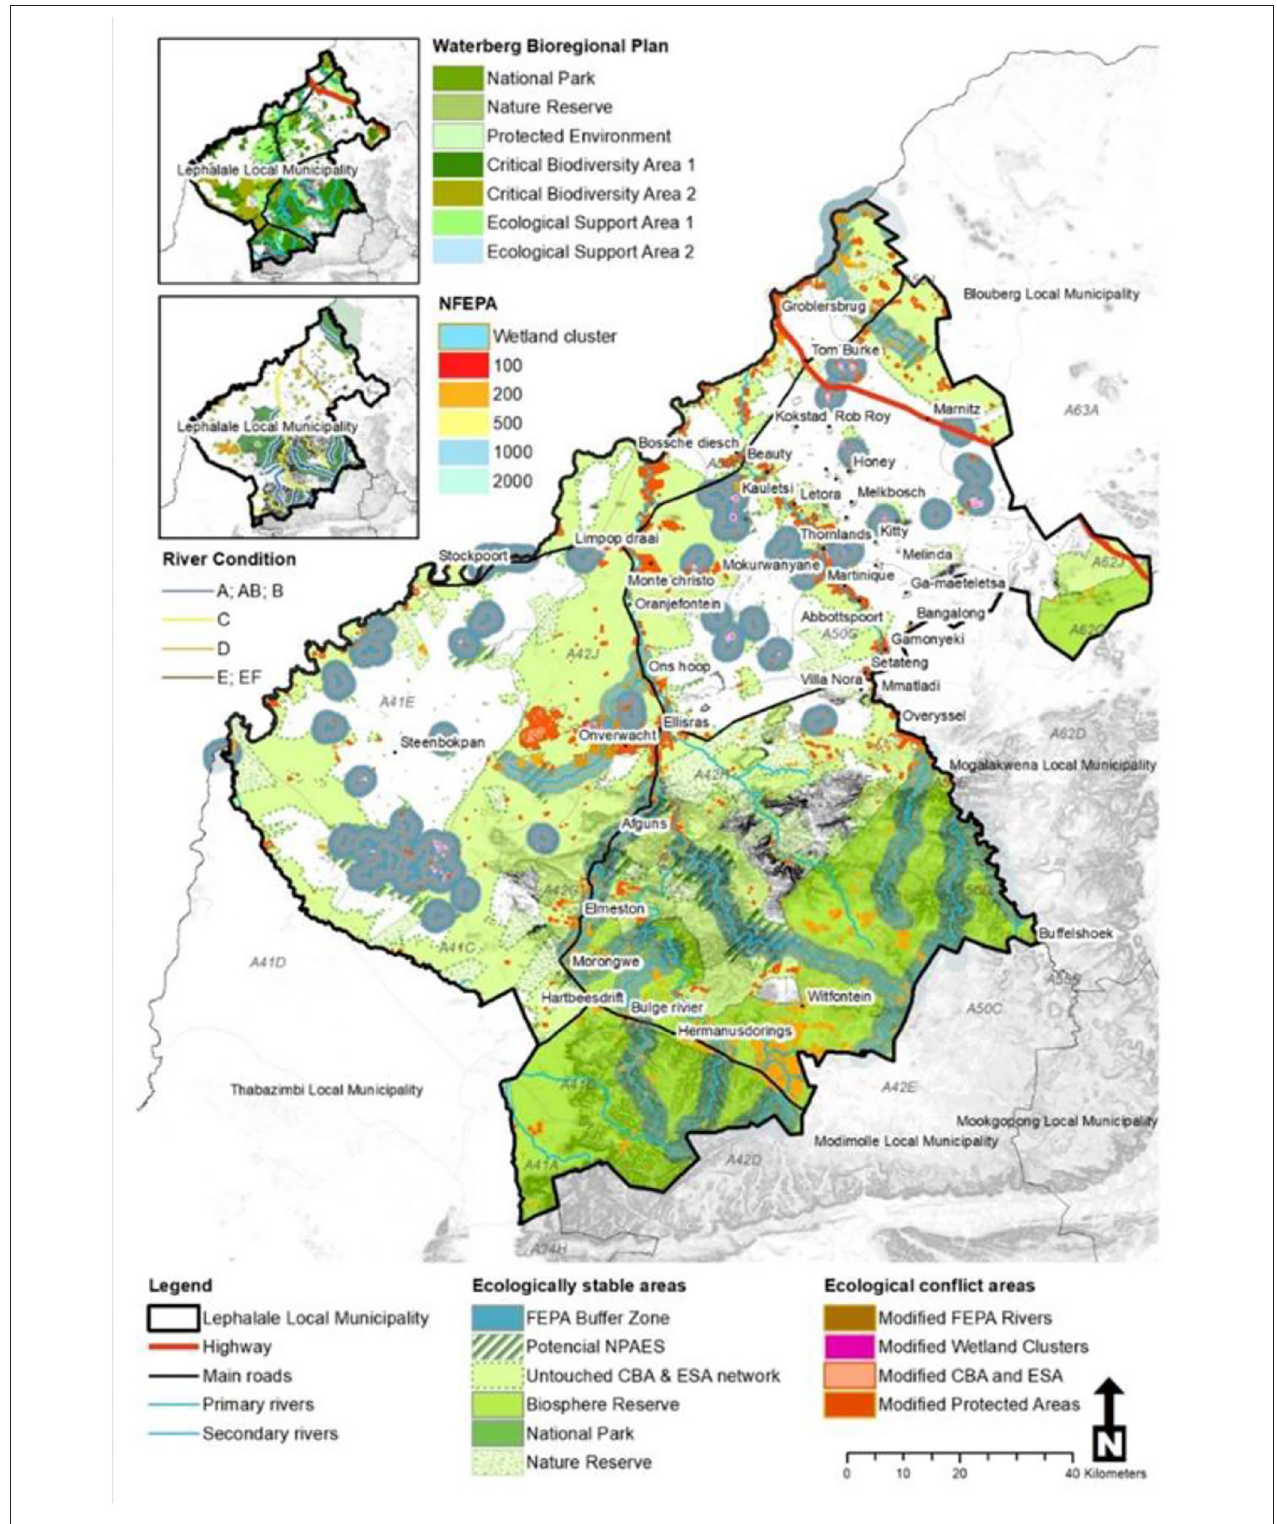
FIGURE 3 | Environmental management requirements. Source: Rohr, 2019, p. 186.